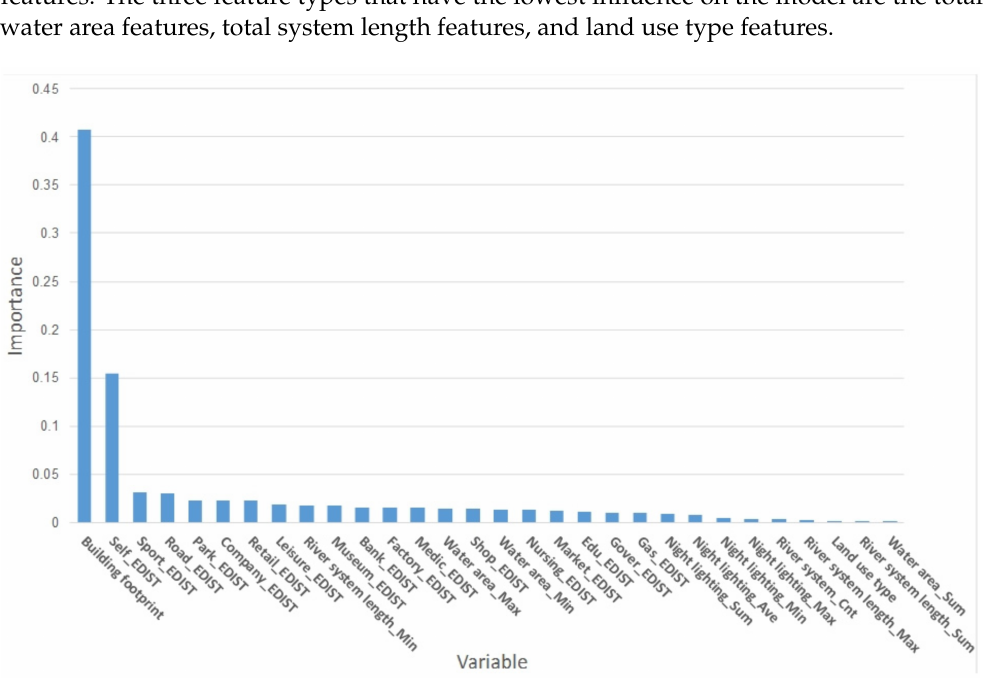
Figure 12. Feature importance in the RF